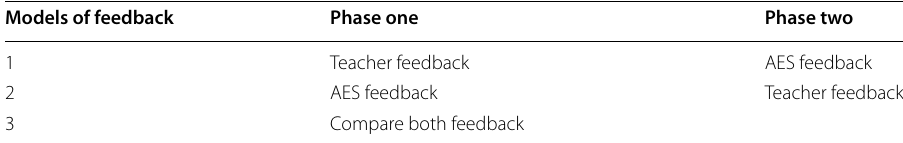
Table 7 Feedback models Models of